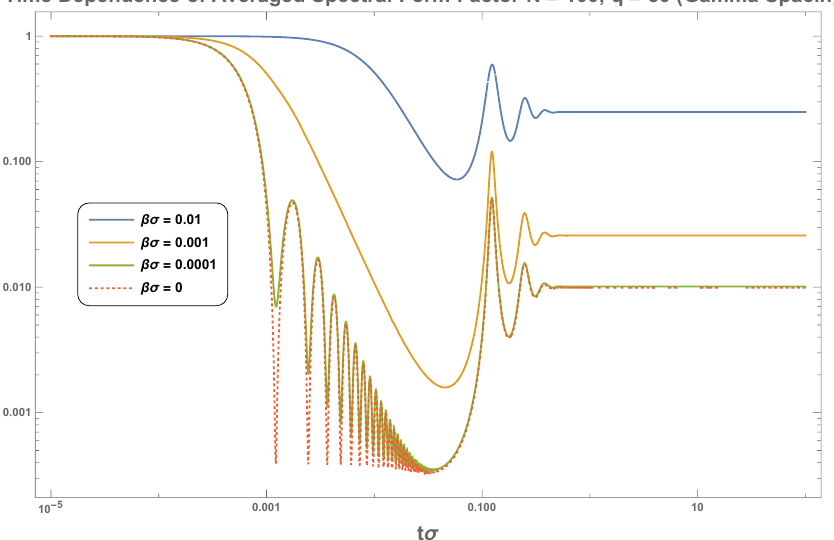
Figure 10 . Above is a Log-Log plot of the averaged spectral form factor at, for a spectrum generated by the i.i.d model with a NNS distribution given by the gamma distribution defined in eq. (3.15). In this plot q = 50 and N = 100 are fixed and the temperature is varied. The energy scale, σ , is related to the average energy spacing between nearest neighbor eigenvalues, h δE i , through the following relation h δE i = ( q + 1) σ